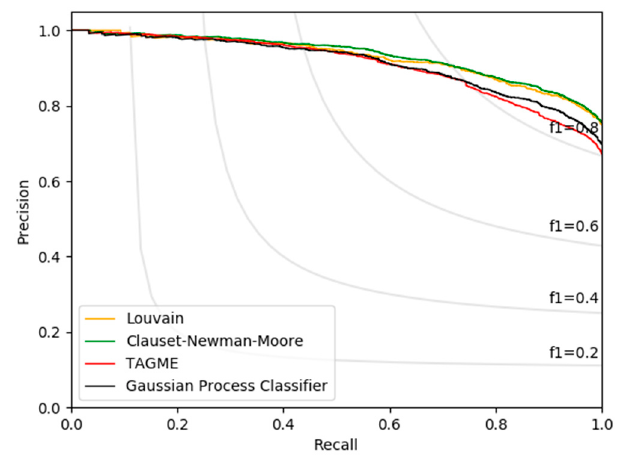
Figure 3. Precision-recall of the two community detection methodology variants, the Gaussian Process Classifier and TAGME [12] baseline. Table 1. Precision, recall and F1 score of Louvain and CNM methodology variants.